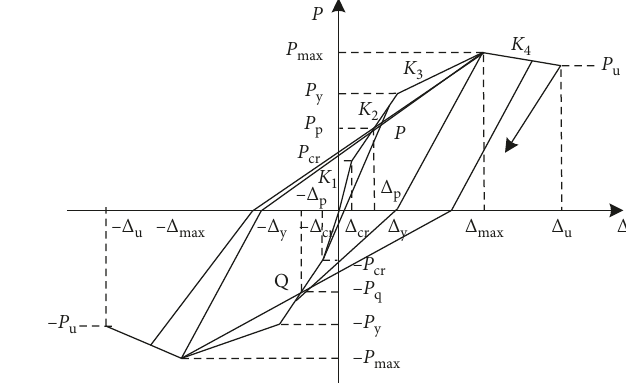
Figure 10: Quad-linear restoring force model.